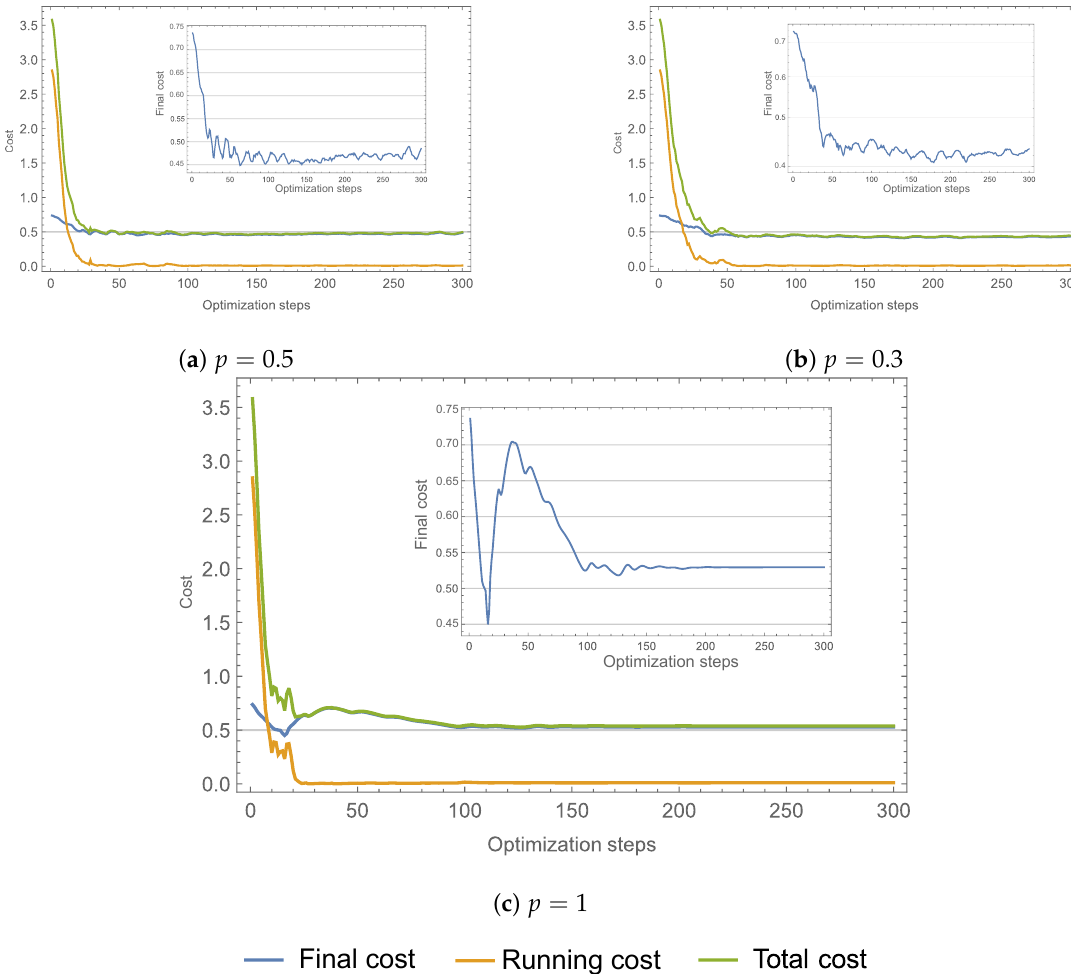
Figure 4. ( a ) The minimization of the cost function computing 100% of the gradients ( p = 1) at each optimization step. ( b ) Using 50% ( p = 0.5) of gradients. ( c ) Using 30% ( p = 0.3) of gradients. The smaller figures show the final